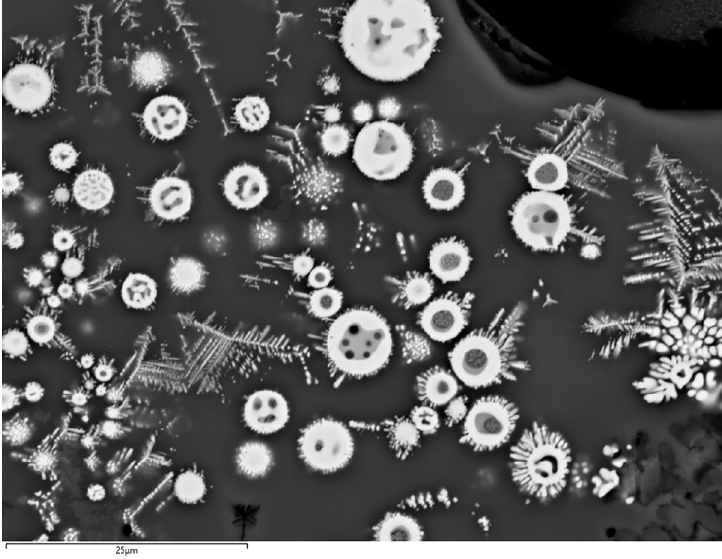
Fig 12. BSE micrograph of G11 showing numerous Cu-based prills of various sizes and some skeletal cuprite embedded in the slag. (Scale = 25 μ